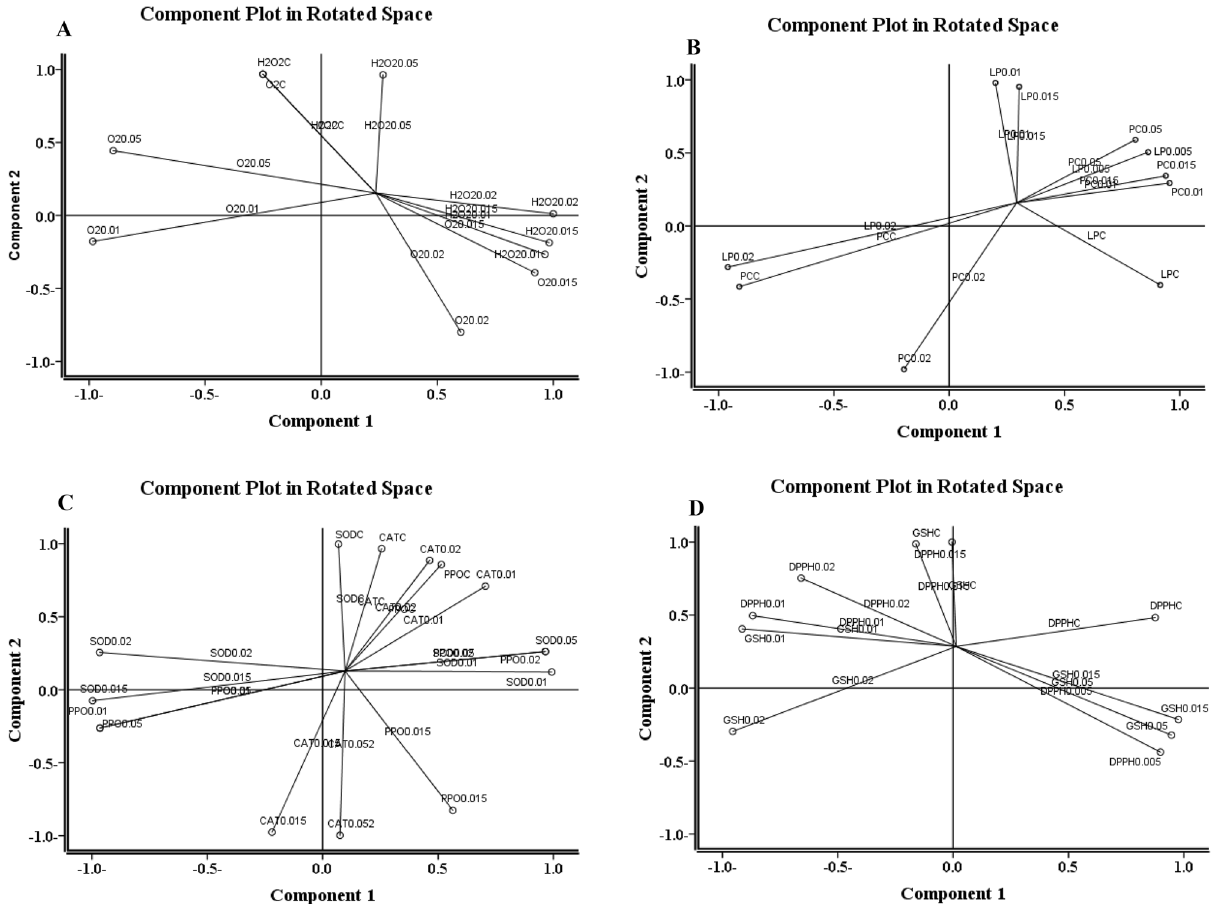
Figure 5. Environmental computing of different malathion concentration (0, 0.005, 0.01, 0.015, and 0.02 mg/ ml) and developmental stage effect (5th larval instar, and adult male) in form of principal component analysis (PCA). The PCA was analyzed the two different component, which applied for reactive oxygen species concentration (ROS), (inform of hydrogen peroxide (H 2 O 2 ), superoxide anion radical (O 2 •- )) ( A ), macromolecules damage (inform of protein carbonyls amount and lipid peroxides concentration) (B), enzymatic antioxidant response (inform of superoxide dismutase (SOD), catalase (CAT), and polyphenol oxidase (PPO)) ( C ), and finally non-enzymatic antioxidant response (inform of anti-radical 2,2-diphenyl-1- picrylhydrazyl (DPPH) and antioxidant glutathione reduced (GSH)) ( D ) in the gut homogenates of Hermetia